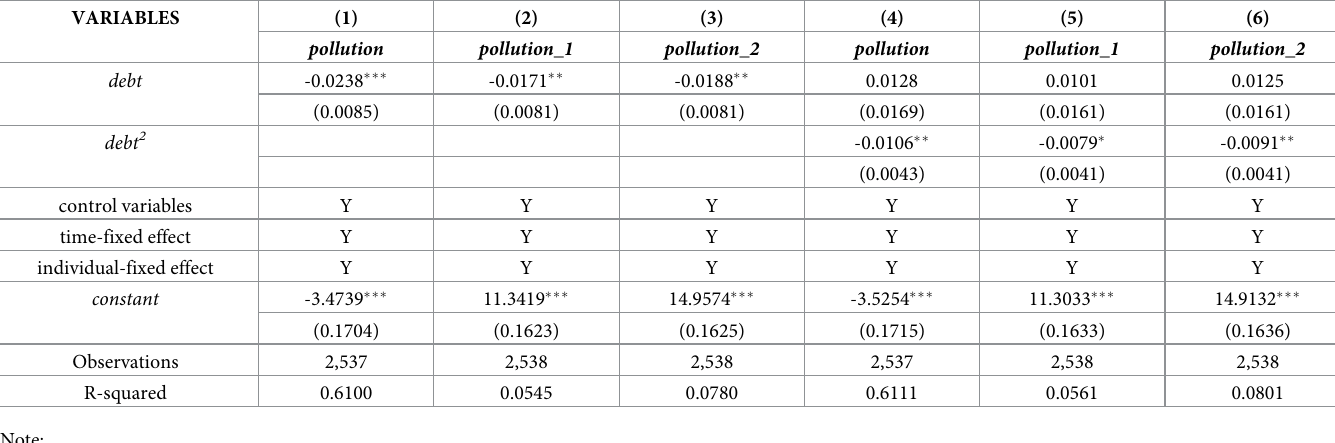
Table 3. Benchmark regressions.